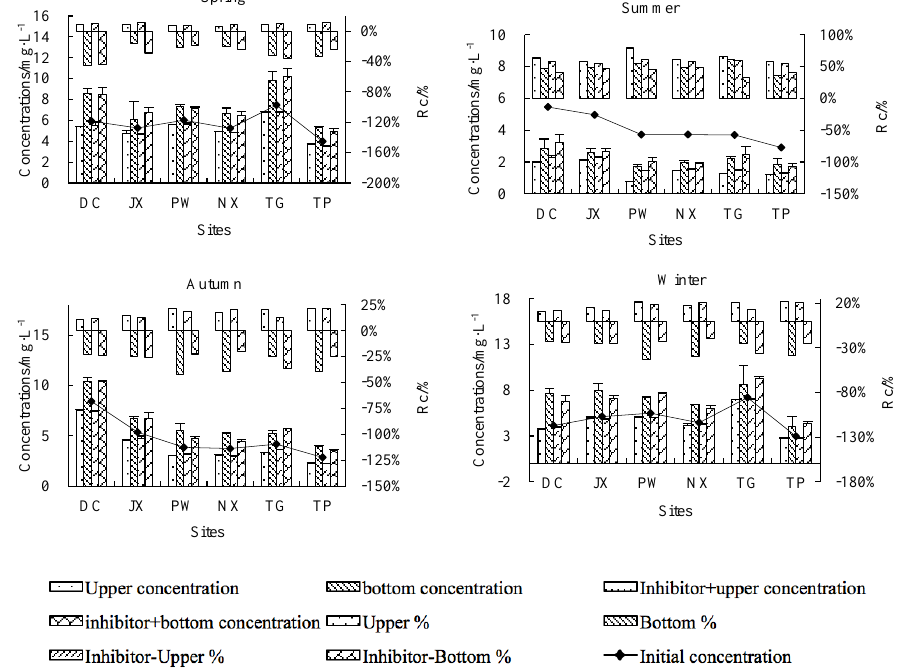
Figure 3. Initial TN (total N) concentrations (line), final upper- and bottom-layer TN concentrations (lower histogram) and percent change from initial TN concentrations (upper histogram). A negative percentage indicates an increase in concentrations and vice versa.